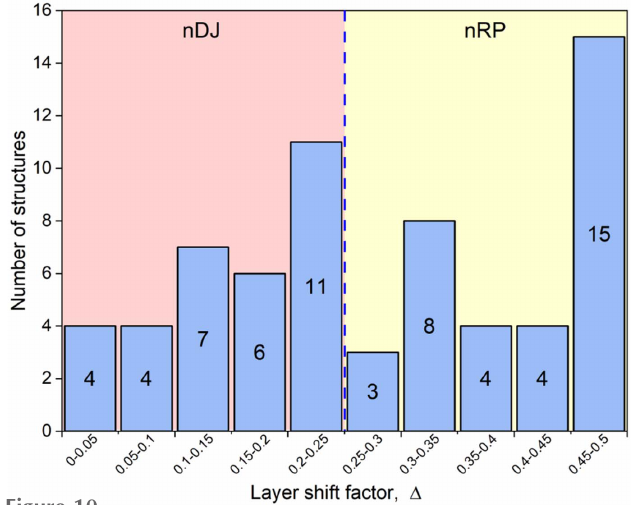
Figure 10 Histogram of layer shift factor values ( (cid:2) ) for P 2 1 / a and P 2 1 / c structures from Table 4. Note that (cid:2) consists of two components ( (cid:2) 1 , (cid:2) 2 ) but by symmetry (cid:2) 1 = (cid:2) 2 therefore only one of these is shown.